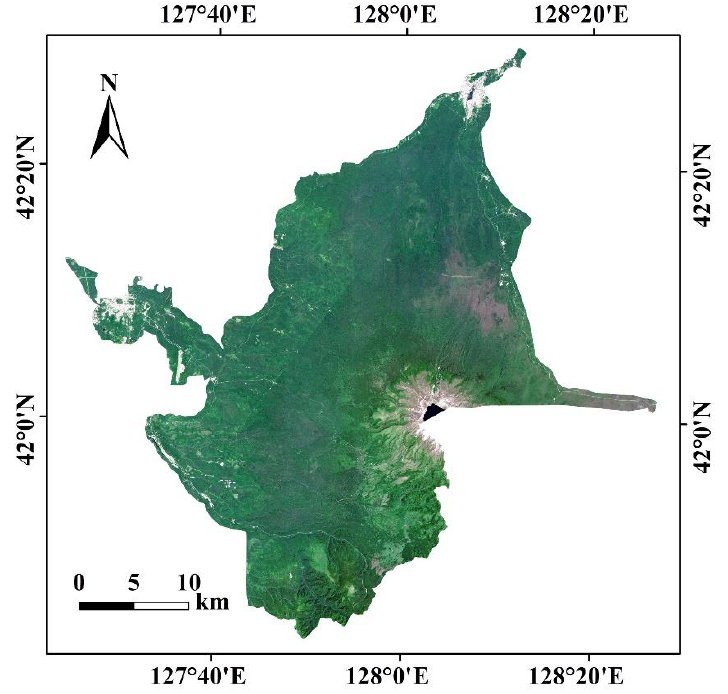
Figure 1. Location of the study site. The RGB composition of Sentinel-2 from 27 June 2019 (B4, B3 and B2).